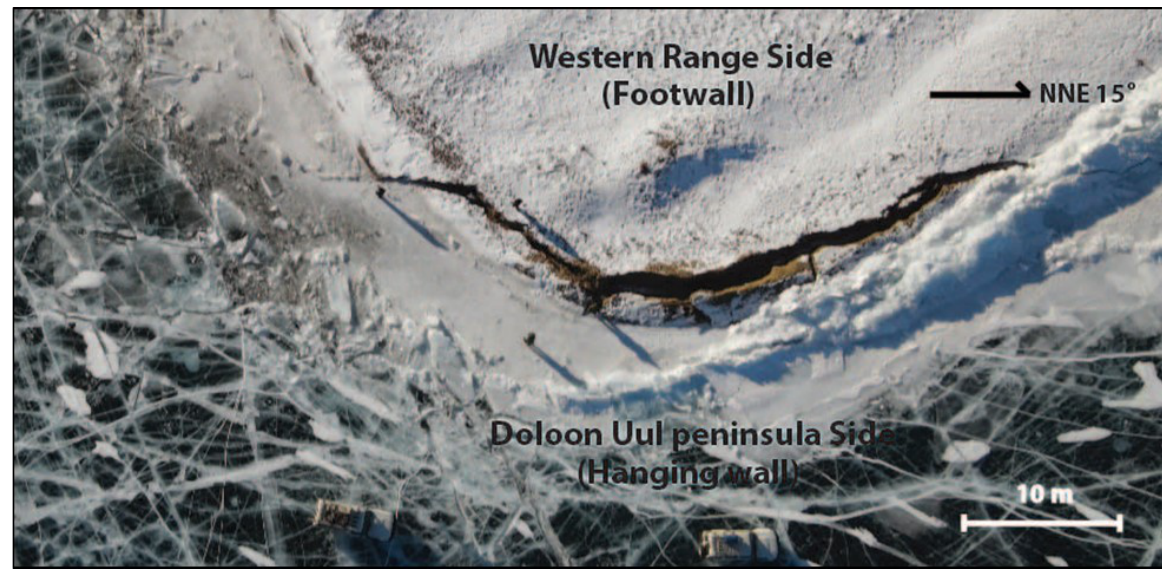
Fig. 3. A drone image for the big crack. It is only site with considerable surface offset that is most likely associated with the earthquake during our field route. The western side (Footwall) moves upward relative to the eastern side (Hangingwall). The people and cars provide for scale. Image by Bayaraa.